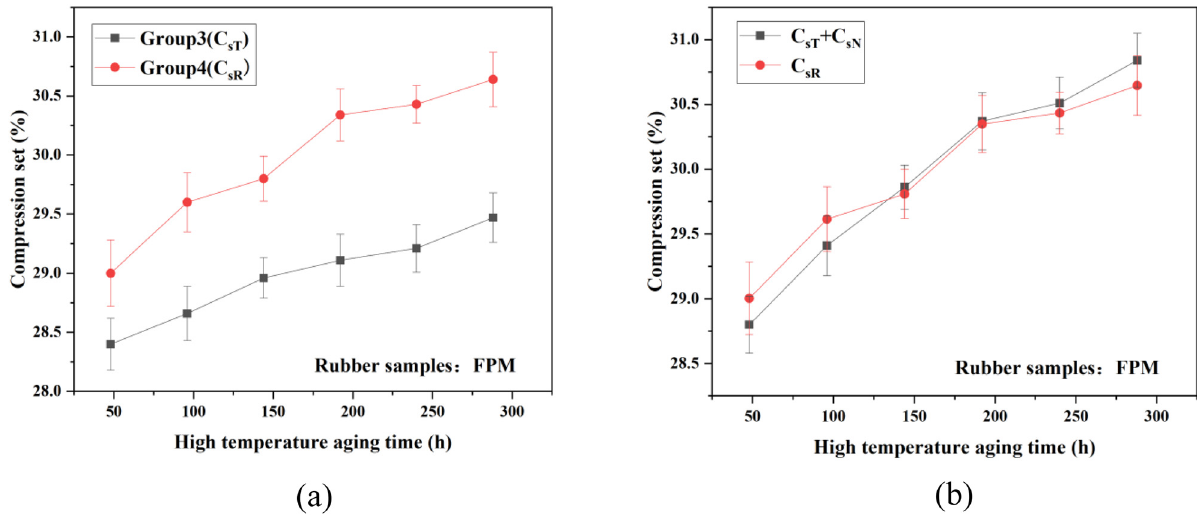
Figure 12: Compression set test results of FPM of ( a ) C sT and C sR , and ( b ) C sT + C sN and C sR